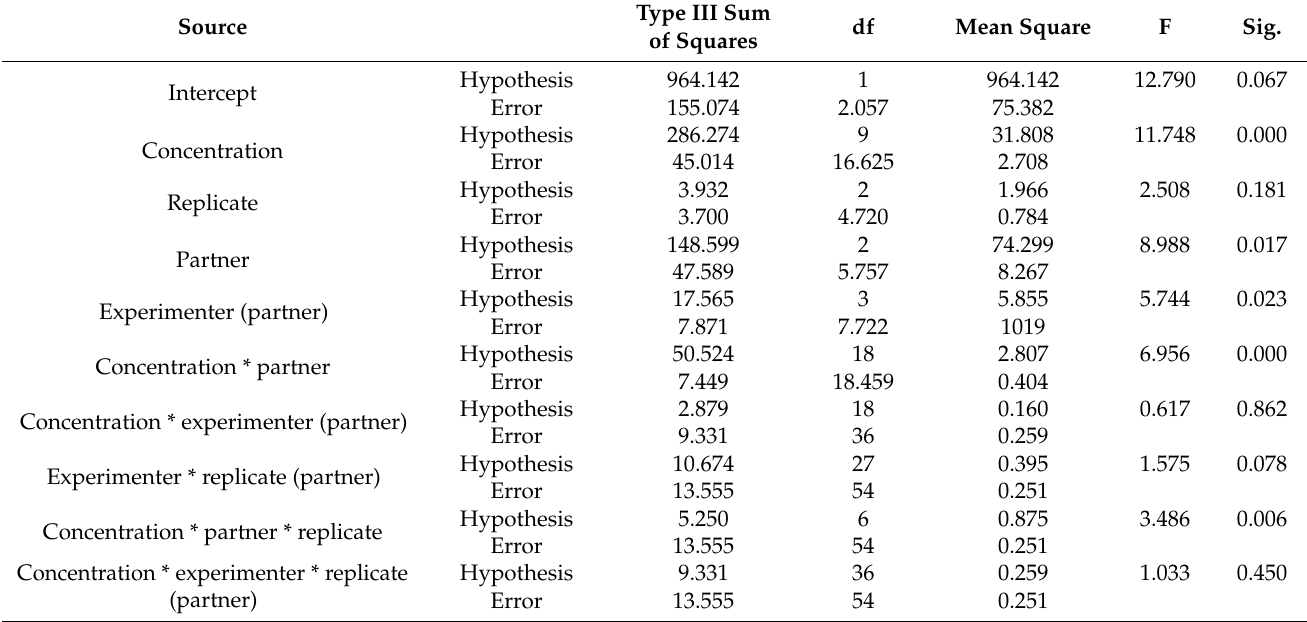
Table 2. Results of the nested (hierarchical) ANOVA showing type III sum of squares as an estimate of the variation caused by the different factors and their interactions (sources, interactions of two or more factors indicated by *) in comparison to the variation caused by the respective error terms. The degree of freedom (df) values are used to calculate the mean squares of the respective sources, and their ratio provides (hypothesis/error) the